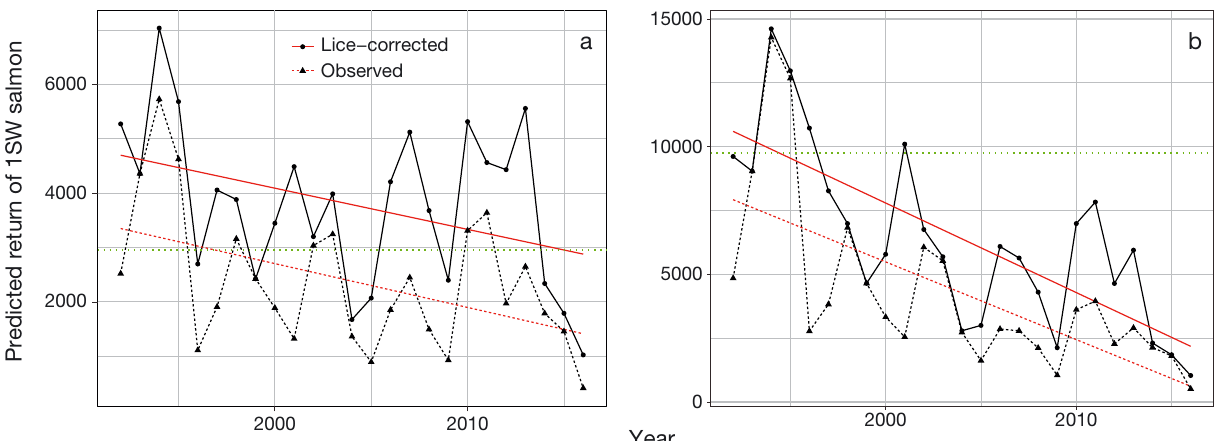
Fig. 7. Observed ( S i ) and ‘lice-corrected’ ( Se i ) returns of 1 sea-winter (1SW) Erriff River Atlantic salmon to (a) the river and (b) the Irish coast. The green line is peak recruitment ( Rp ) estimated from the Ricker curve (see Fig.